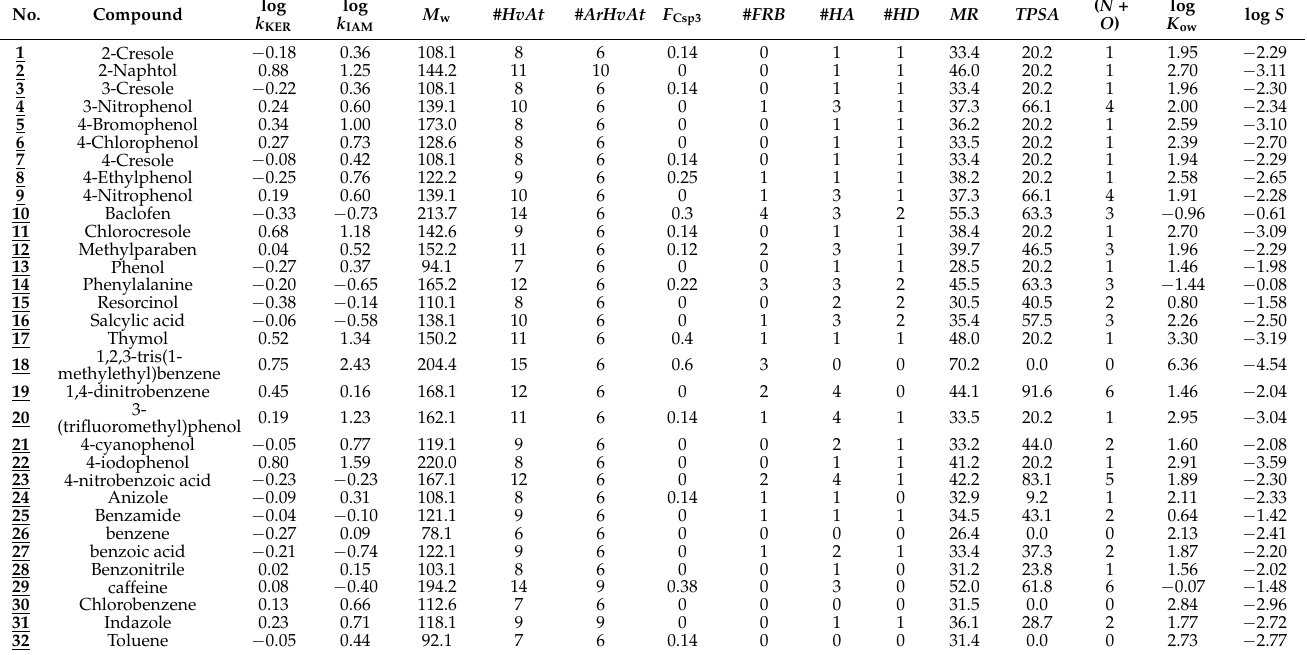
Table 1. Chromatographic retention factors and calculated physico-chemical properties of compounds 1 to 32 .